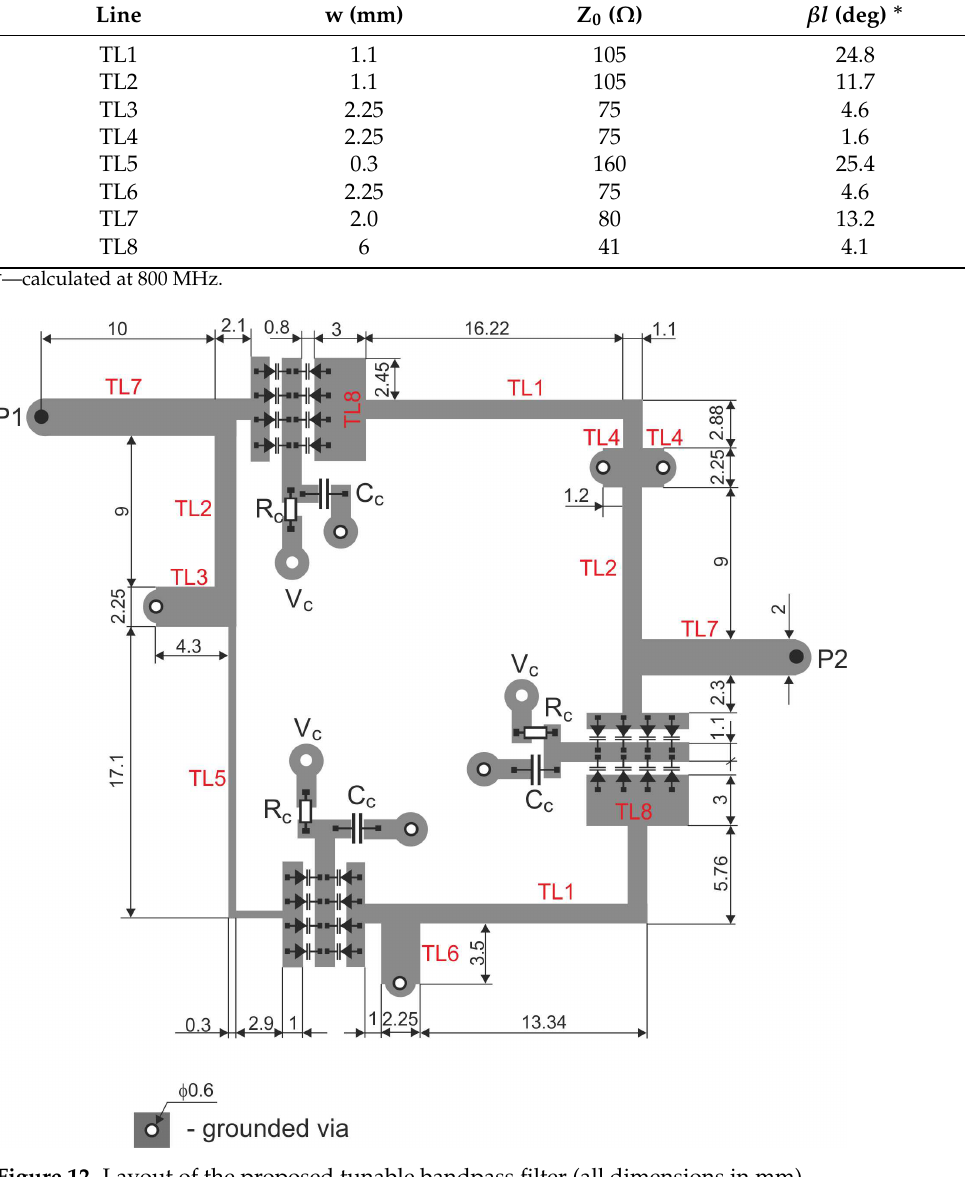
Figure 12. Layout of the proposed tunable bandpass filter (all dimensions in